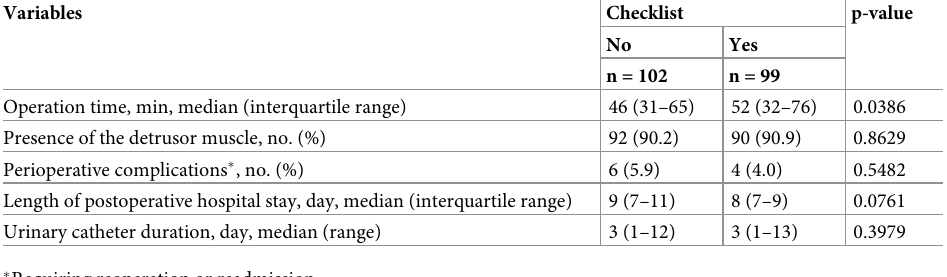
Table 3. Perioperative